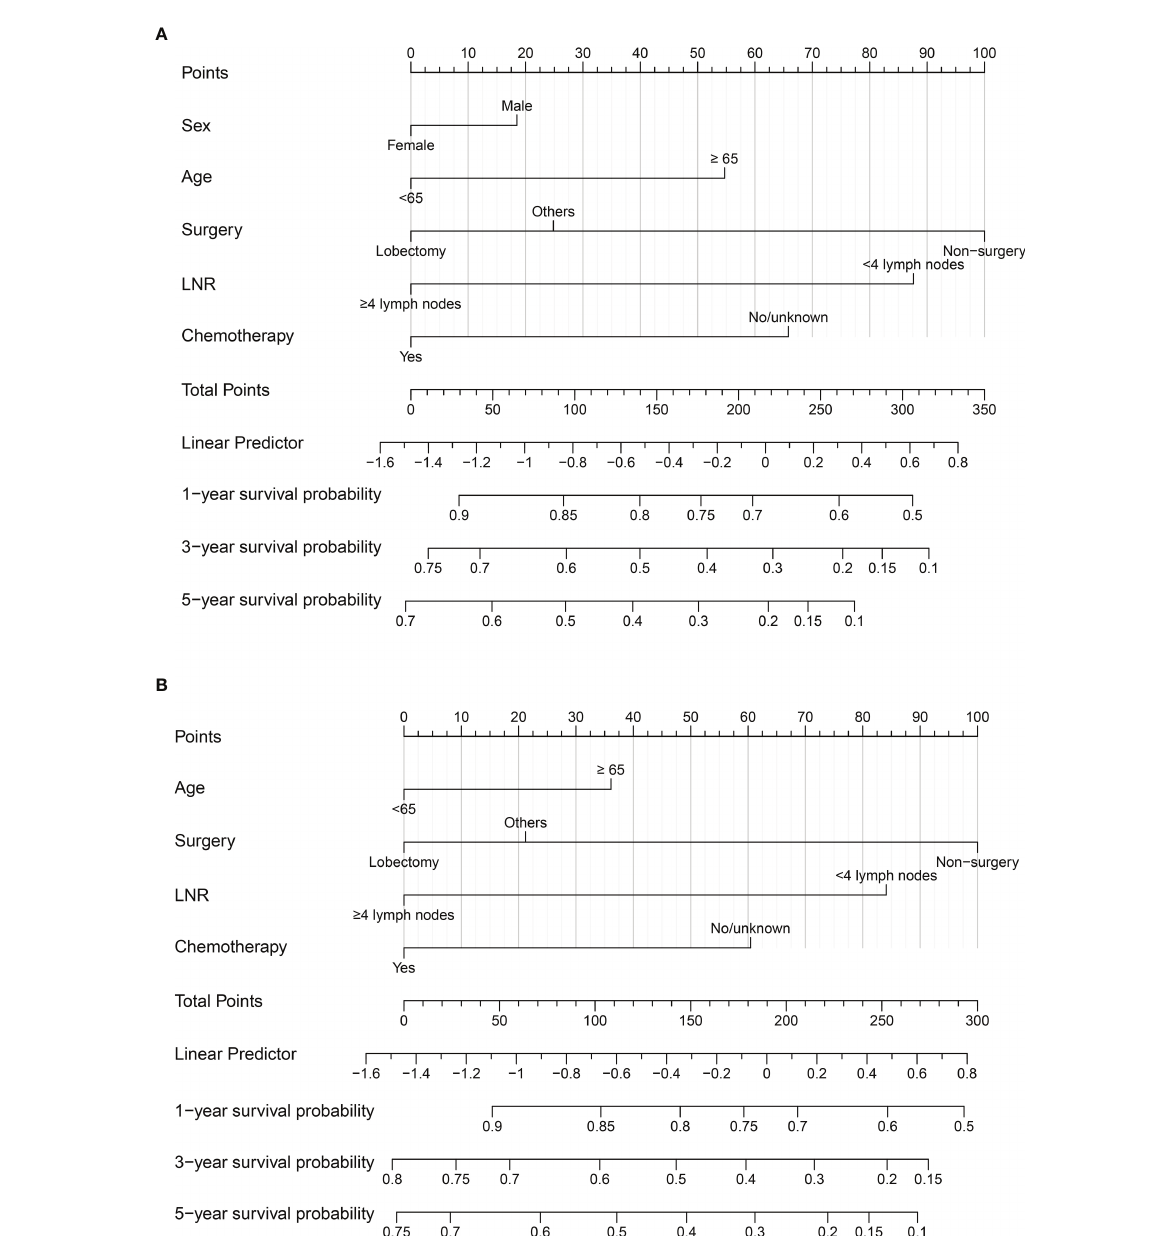
FIGURE 2 (A) Nomogram to predict 1-, 3-, and 5-year OS probability for early-stage T1-2N0M0 SCLC patients; (B) Nomogram to predict 1-, 3-, and 5- year LCSS probability for early-stage T1-2N0M0 SCLC patients. LNR, lymph nodes removal; SCLC, small cell lung cancer; OS, overall survival; LCSS, lung cancer-speci fi c